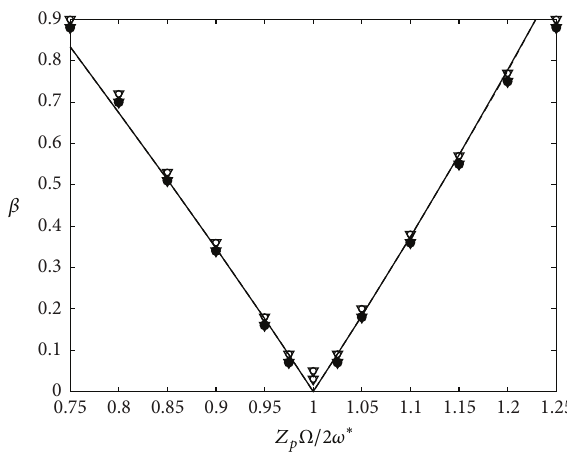
Figure 3: Dynamic instability region of a rotating ship shaft with 𝑍 𝑝 = 5. “—,” instability region boundary by Floquet’s method; “ e ” and “ I ,” stable and unstable results by DSC method.